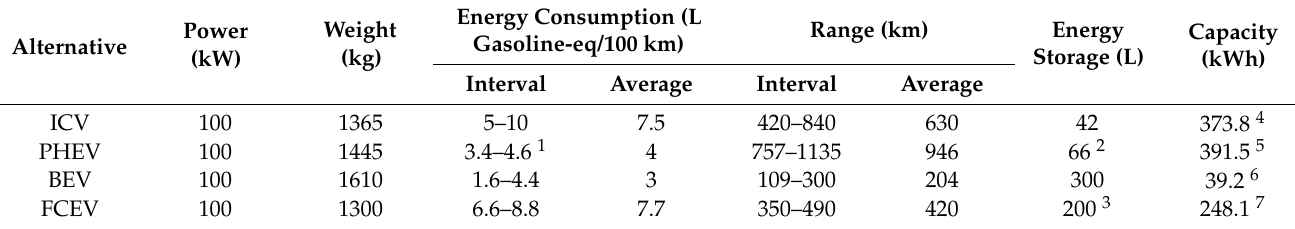
Table 1. Car characteristic data used in the analysis.